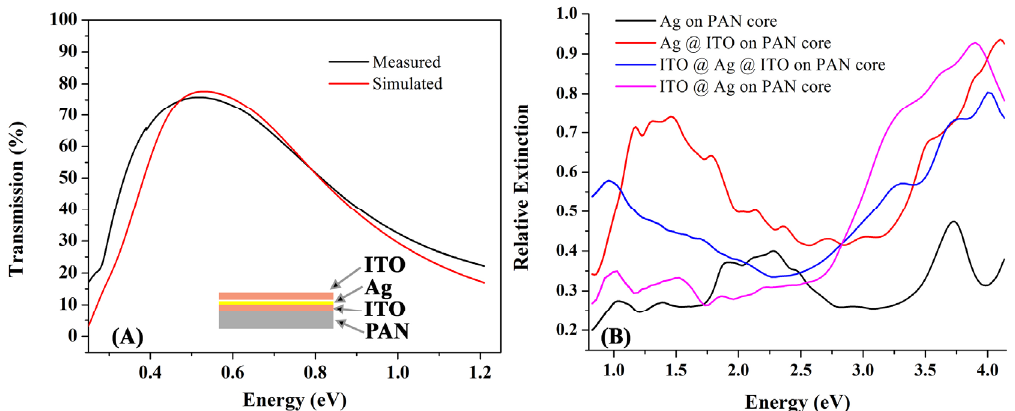
Figure 9. ( A ) Simulated and experimental transmission spectra of planar ITO/Ag/ITO multilayer structure showing excellent agreement. The mismatch in the shorter wavelength region might be due to sample nonuniformity. ( B ) Simulated extinction coefficient spectra of various nanostructure arrays. The spectra follow the same trend as the experimental data in Figure